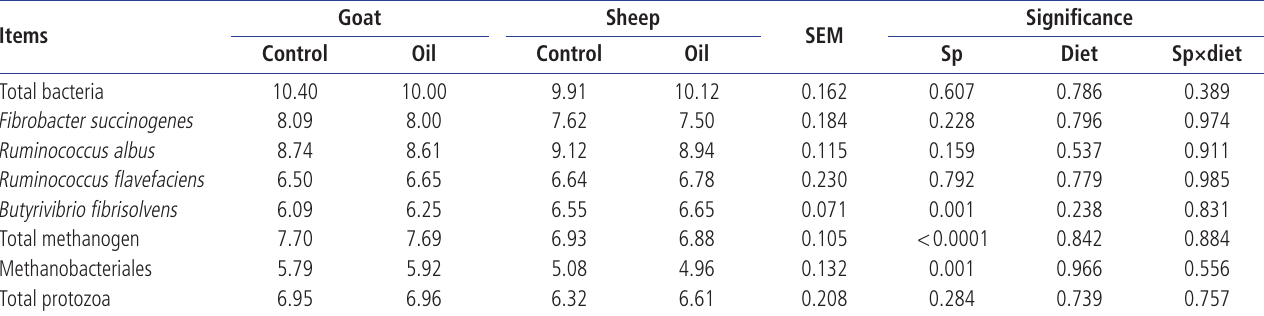
copy number/mL) in goat and sheep under different dietary treatments 10 Goat Sheep